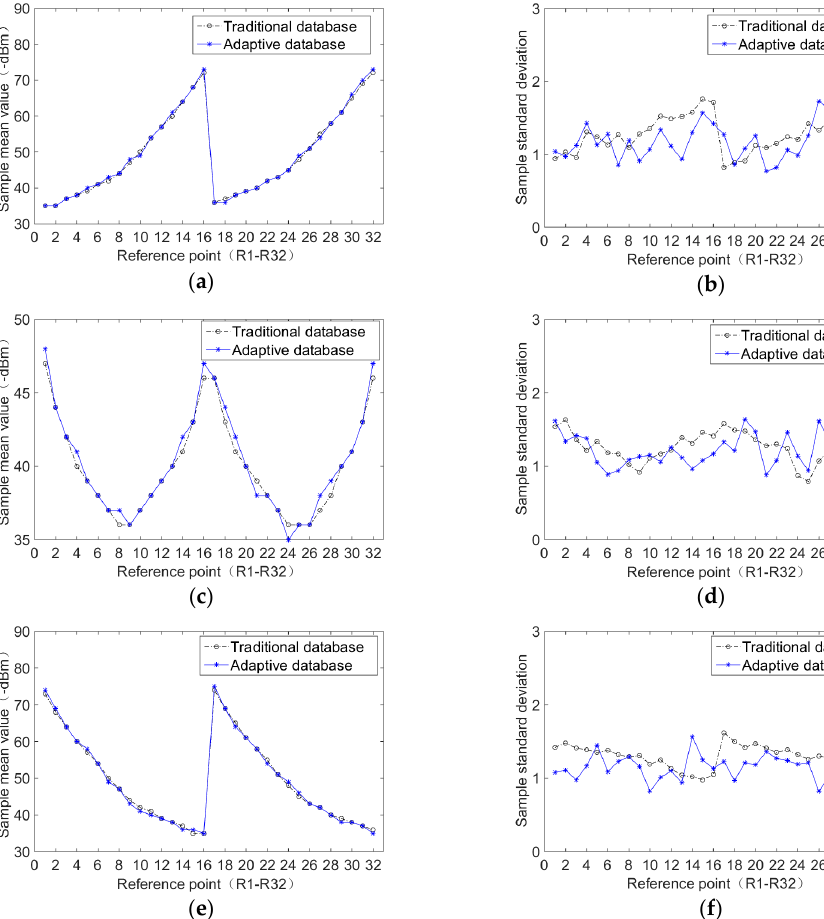
Figure 9. Comparison of radio fingerprint samples statistical distribution between the adaptive radio fingerprint database and the traditional radio fingerprint database: ( a ) mean value of AP 1 ; ( b )